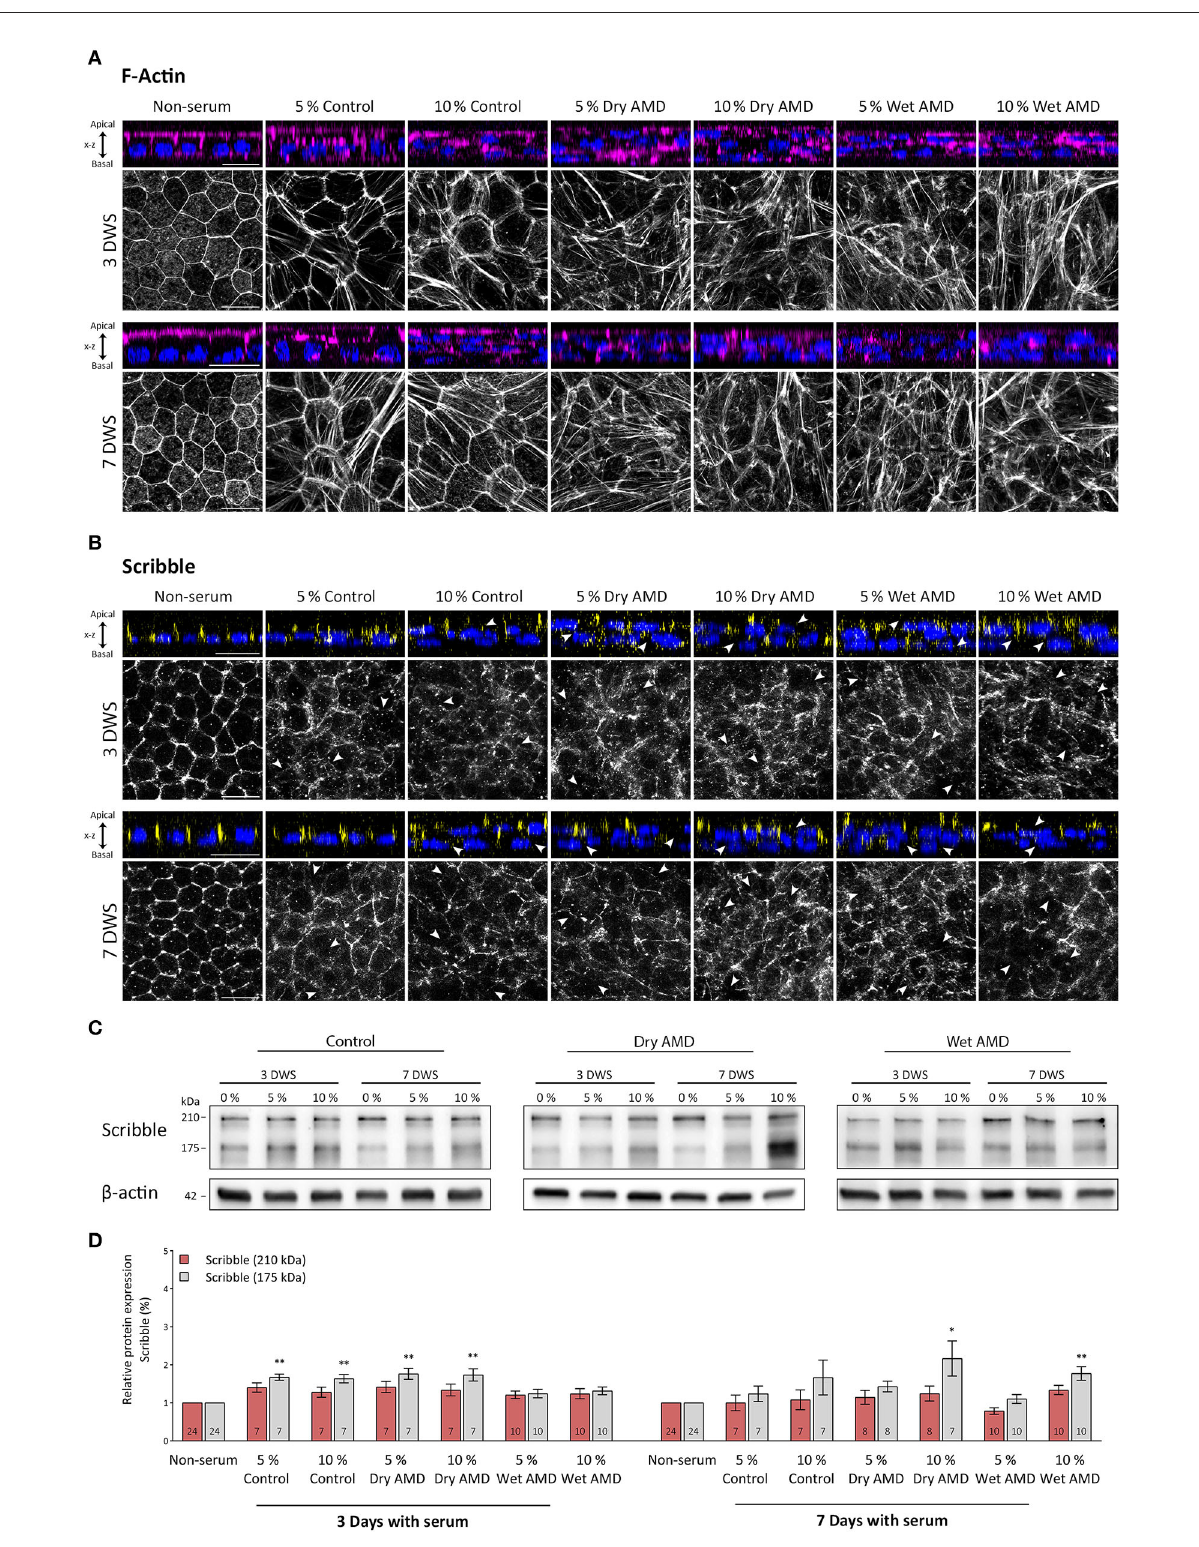
FIGURE3 Expression pattern of actin and Scribble proteins in hRPE cells after serum exposure. (A) Orthogonal views and corresponding z-stack maximum projections showing actin (magenta) in cells without serum and after the serum exposure of both control patients and patients with AMD patients. (B) Orthogonal views and corresponding z-stack maximum projections showing Scribble (yellow) in cells without serum and after